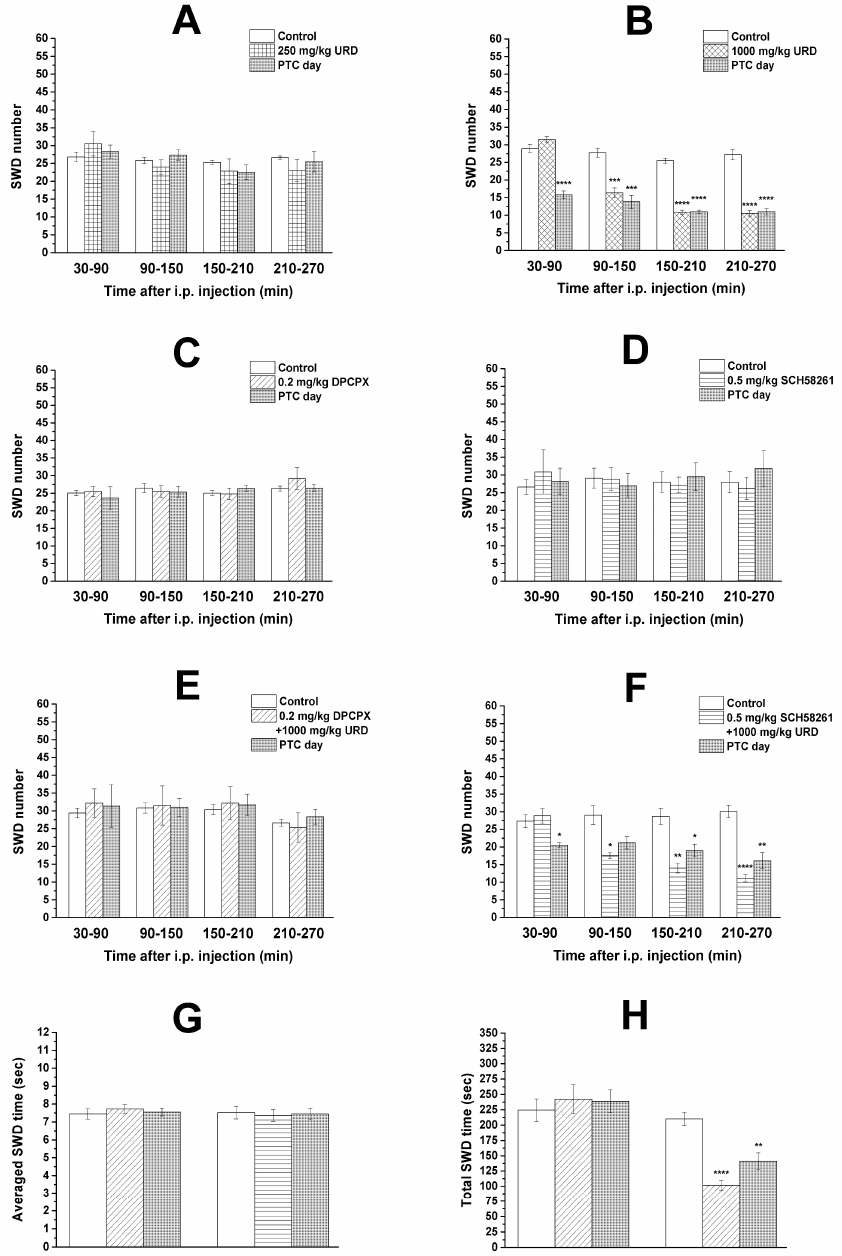
Figure 2. Effect of uridine (i.p. 250 mg/kg; ( A ); i.p. 1000 mg/kg; ( B )) alone, DPCPX (i.p. 0.2 mg/kg) ( C ) and SCH 58261 (i.p. 0.5 mg/kg) ( D ) alone as well as combined administration of DPCPX (i.p. 0.2 mg/kg) with uridine (i.p. 1000 mg/kg) ( E ) and SCH 58261 (i.p. 0.5 mg/kg) with uridine (i.p. 1000 mg/kg) ( F ) on SWD number. Influence of combined administration of DPCPX (i.p. 0.2 mg/kg) with uridine (i.p. 1000 mg/kg) and SCH 58261 (i.p. 0.5 mg/kg) with uridine (i.p. 1000 mg/kg) on averaged SWD time ( G ) and total SWD time ( H ) between 150 and 210 min. Abbreviations: Co, control; DPCPX, 1,3-dipropyl-8-cyclopentylxanthine; D + Urd: DPCPX + URD; i.p., intraperitoneal; PTC or PTC day, post-treatment control day; SCH 58261, (7-(2-phenylethyl)-5-amino-2-(2-furyl)-pyrazolo-[4,3-e]-1,2,4-triazolo [1,5-c]pyrimidine); S + Urd: SCH 58261 + URD; SWD, spike-wave discharge; URD, uridine. *: p < 0.05, **: p < 0.01, ***: p < 0.001, ****: p < 0.0001. Injection of both DPCPX and SCH 58261 in combination with uridine did not change averaged time of SWDs (group 5, DPCPX + uridine: control vs. treatment day, p < 0.7524 and control vs. PTC day, p < 0.9601; group 6, SCH 58261 + uridine: control vs. treatment day, p < 0.9471 and control vs. PTC day, p < 0.9893) (Figure 2G). Consequently, alterations of